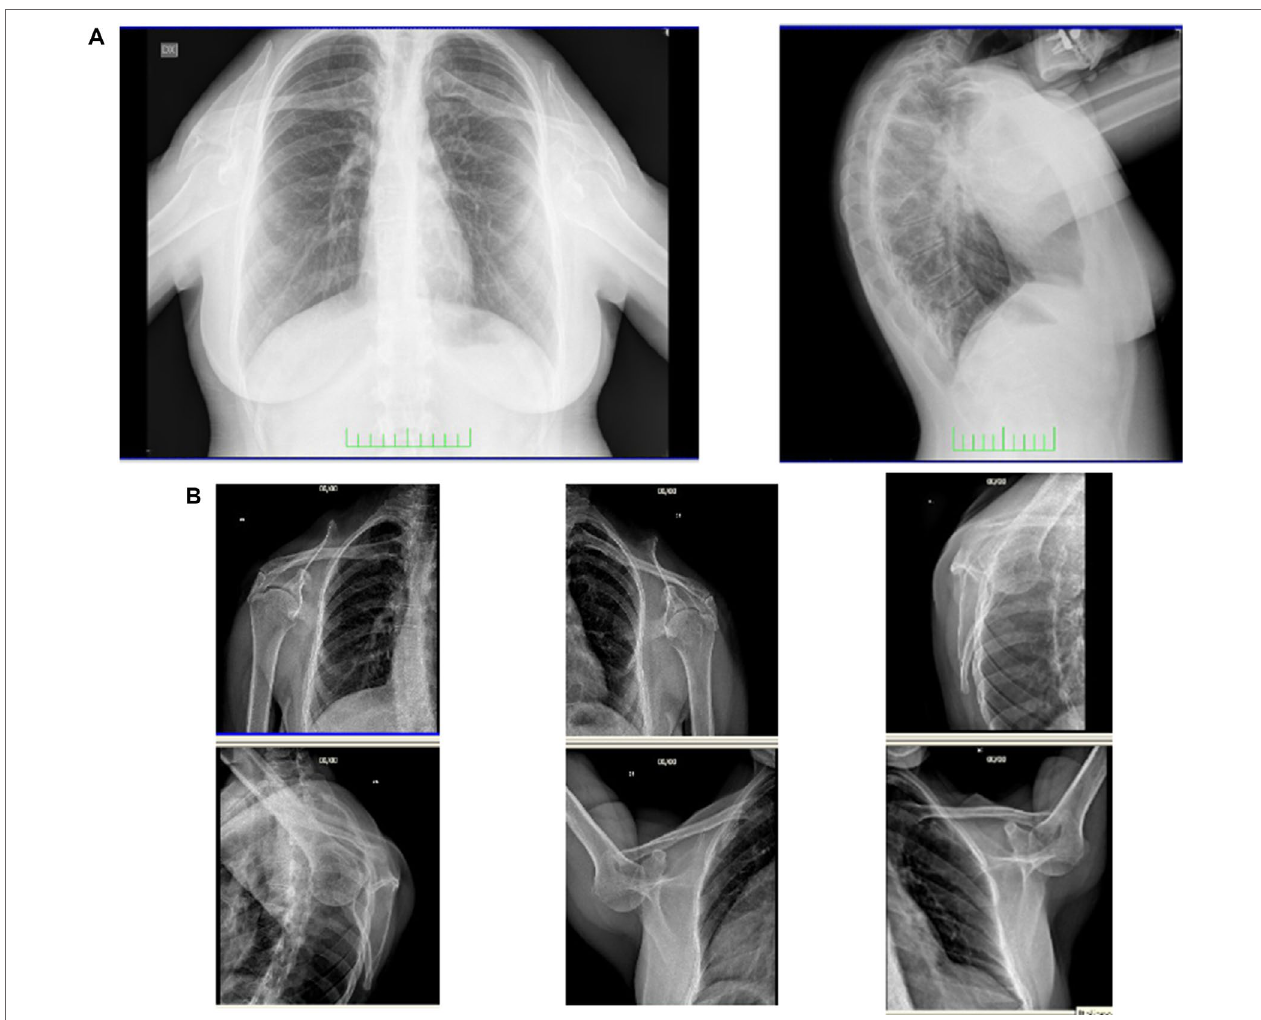
FIGURE 2 | Frontal and lateral radiograph of the patient (A) . Small, low, and laterally set scapulae with the glenohumeral joints lower than normal and down-turned clavicles are shown (B)